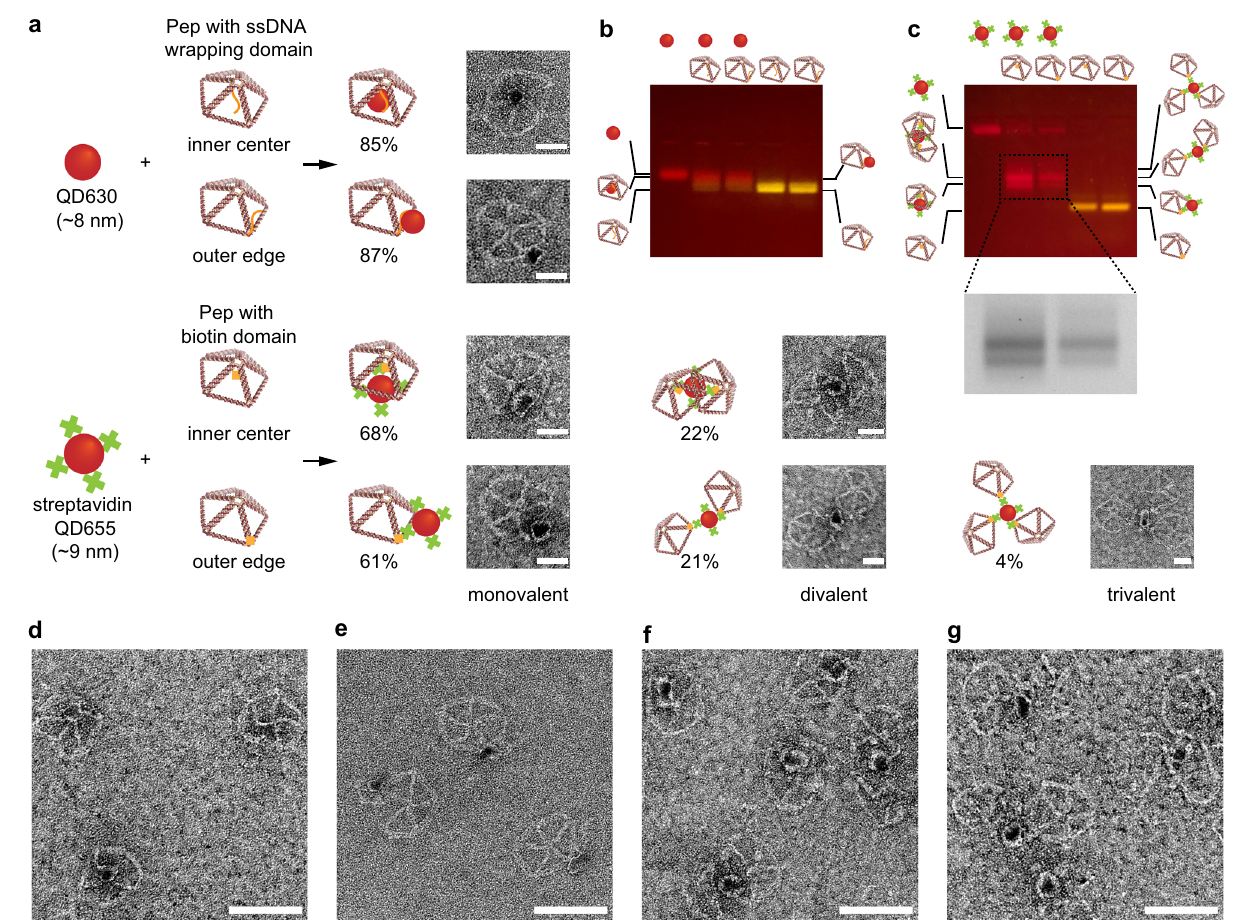
Fig. 3 | Wireframe DNA origami-based chimeric ssDNA wrapping and biotin- streptavidin conjugation. a Schematic and TEM images of pentagonal pyramid (Pep)-QD assemblies using chimeric ssDNA (30nt A*) wrapping or biotin- streptavidin conjugation at the inner center and outer edge of Pep wireframe ori- gami objects. The percentage of mono-, di-, and tri-valent Pep-QDassemblieswere calculatedfromTEMimages(308and337assembliesforPepwith30ntA*domain at the inner center and outer edge, respectively; 257 and 265 assemblies for Pep with biotin domain at the inner center and outer edge, respectively). b AGE (0.8%) image (fourfold excess Pep) of QD630 alone, Pep-30nt A*-QD630 (inner center),